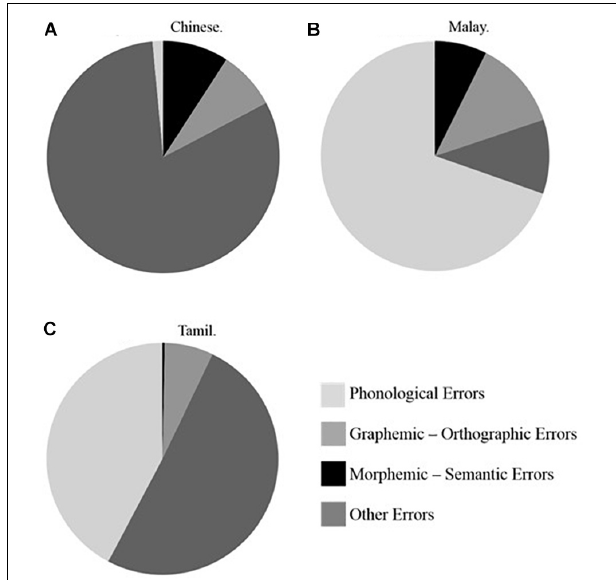
FIGURE 3 | Proportion of Phonological Errors, Graphemic-Orthographic Errors, Morphemic-Semantic Errors, and Other Errors in Chinese (A) , Malay (B) , and Tamil (C) Asian language groups in subsample matched for SES ( N =